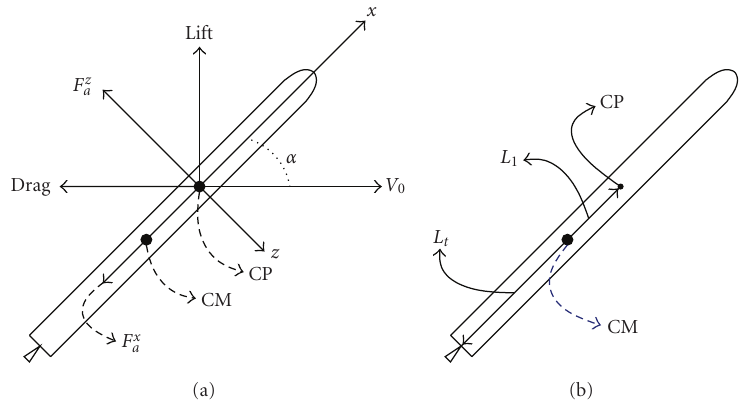
Figure 1: Vehicle diagram.